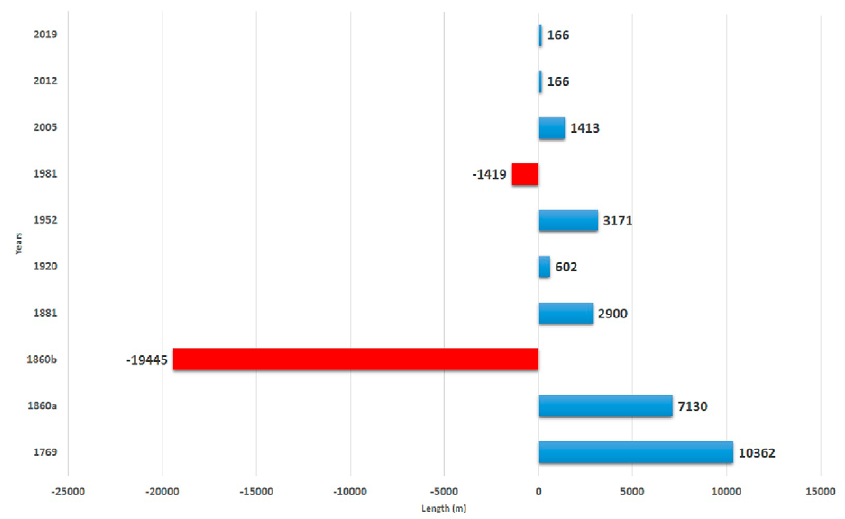
Figure 8. The differences in length for each consecutive analyzed period: 1860a-before incision; 1860b-after